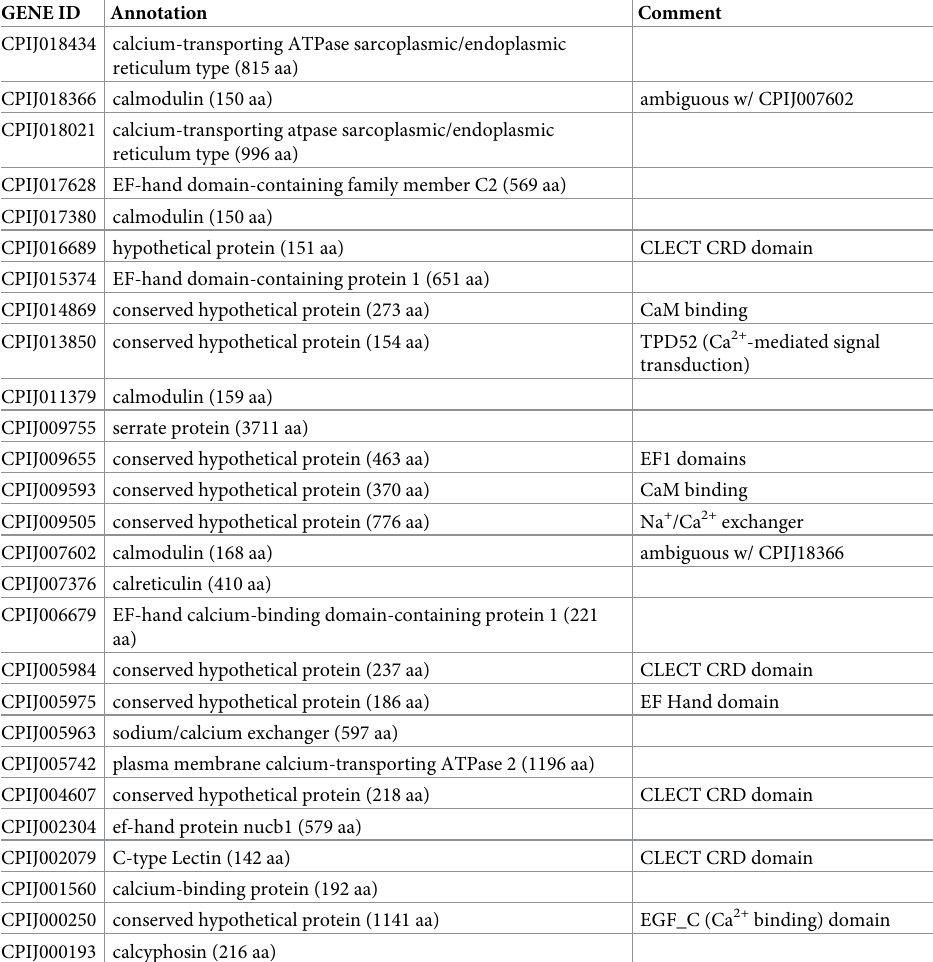
Table 3. Ca 2+ binding proteins detected in the Culex sperm